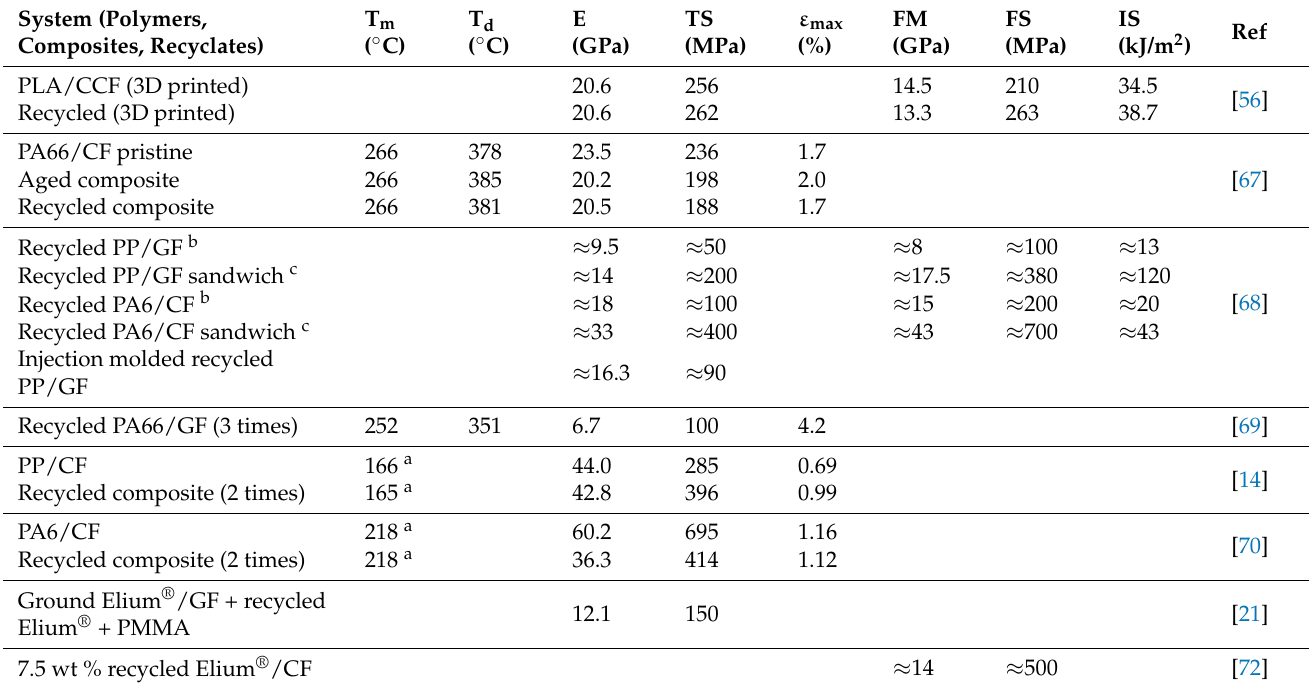
Table 3. Summary of mechanical and thermal properties of the reviewed TPFRP composites and recycled composites. System